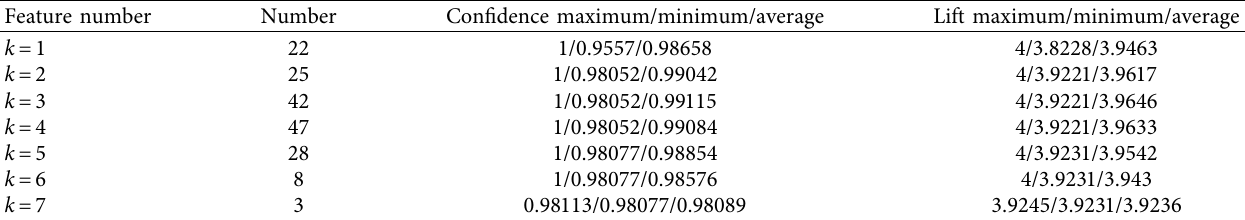
Table 15: Fault diagnosis rules extraction results based on the confidence-ACI